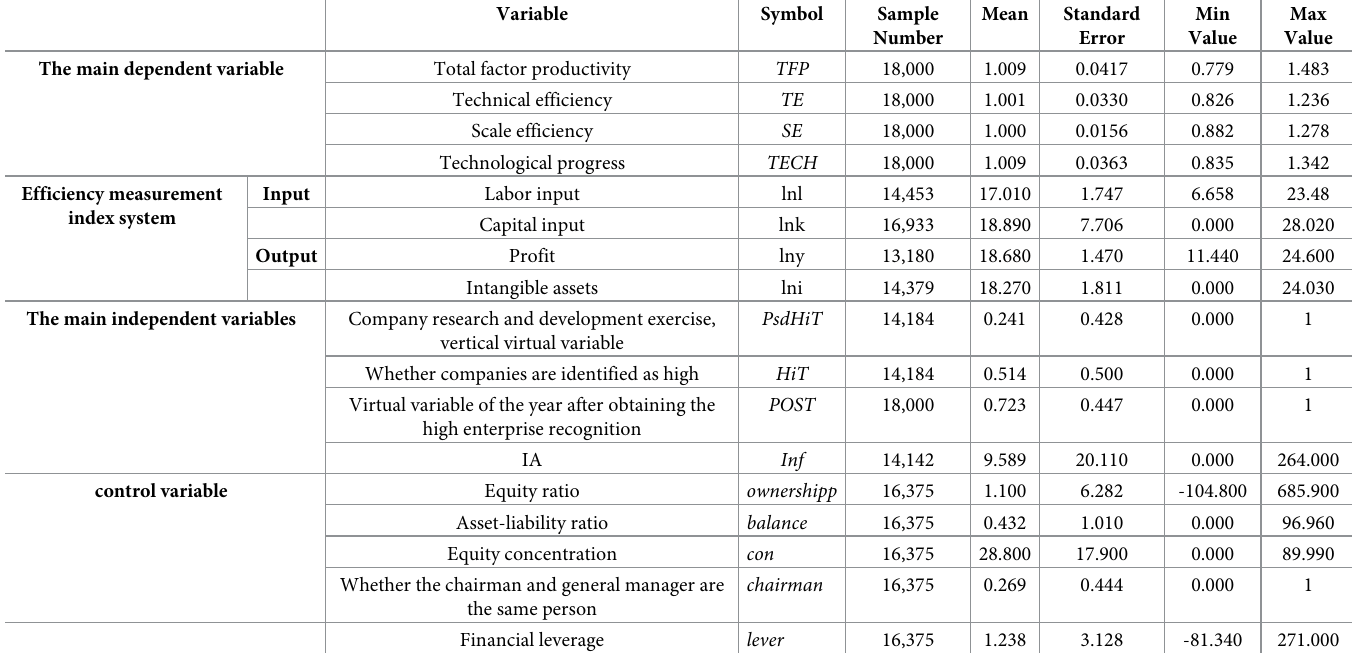
Table 1. Descriptive statistics of the data.